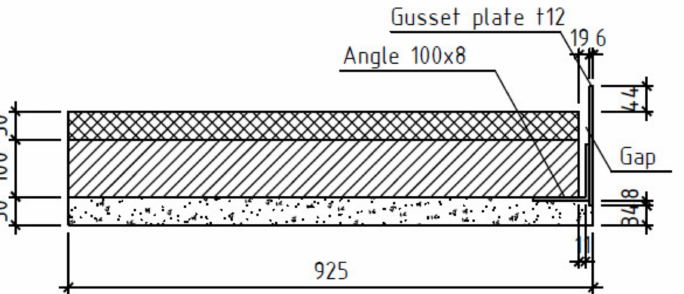
Figure 15. Calculation scheme with a gusset plate. The gaps between the angles and precast reinforced concrete elements are not filled with thermal insulation (units: